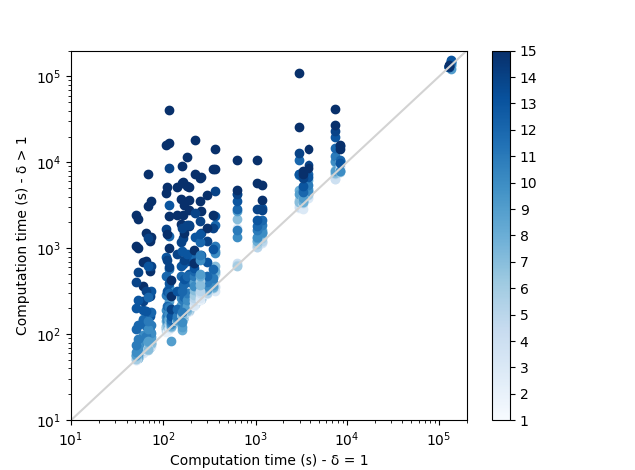
Figure 9. Comparison of the computation times of sequence sets without diversity δ = 1, with sequence sets with diversity δ > 1. The color scale on the right indicates the corresponding value of δ